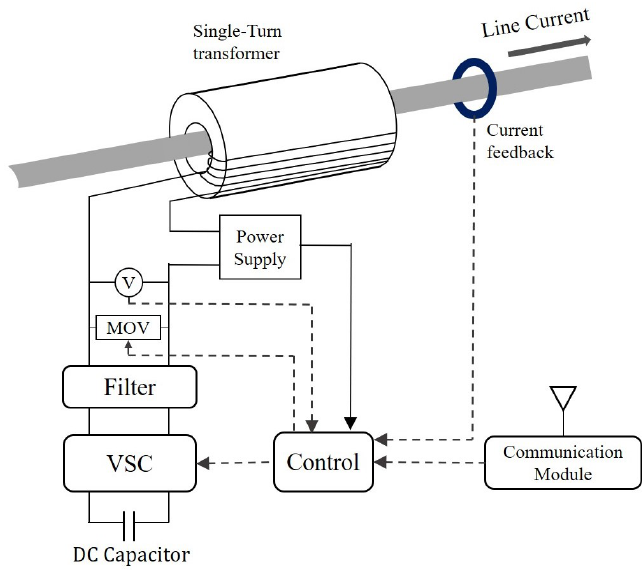
Figure 14. DSSC circuit schematic. Based on Reference